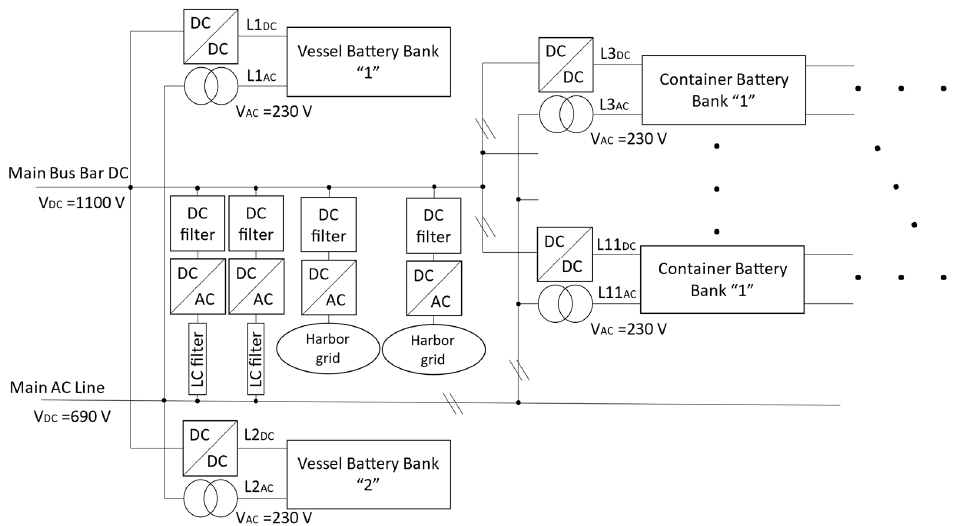
Figure 9. Block diagram of the electrical installation of the electricity storage system with vessel battery banks and stacks of container battery banks.